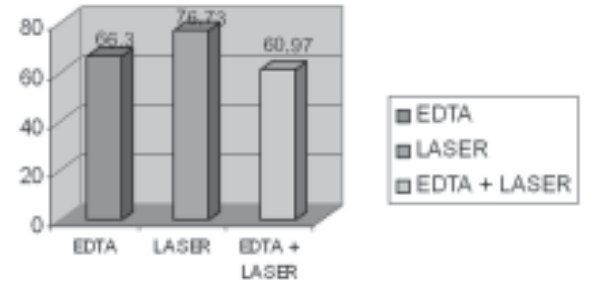
FIGURE 2 - Graph demonstrating the mean positions achieved in relation to the scores assigned to the obturation of the lateral canals, according to the thirds: 1- cervical, 2- middle and 3-